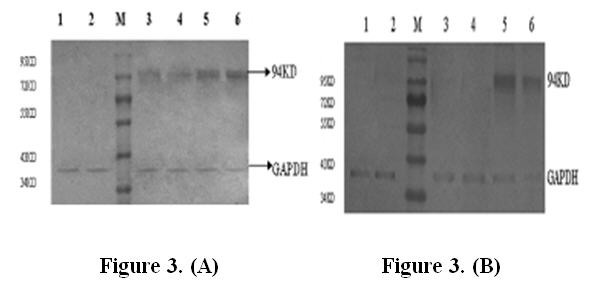
ALV-J envelope glycoprotein expression of DF-1 cells in each in of the groups. (A) Western immunoblot of infected culture treated with miRNA. Lane M: protein ladder; lane 1: mi-gag1318; lane 2: mi-gag1356; lane 3: mi-gag1623; lane 4: mi-gag1971; lane 5: negative control; lane 6: null vector control. (B) Western immunoblot of infected cultures treated with miRNA. Lane M: protein ladder; lane 1: mi-g1318-e1384; lane 2: mi-p2516-e1384; lane 3: mi-g1318-p2516; lane 4: mi-g1318-p2516-e1384; lane 5: negative control; lane 6: null vector control.